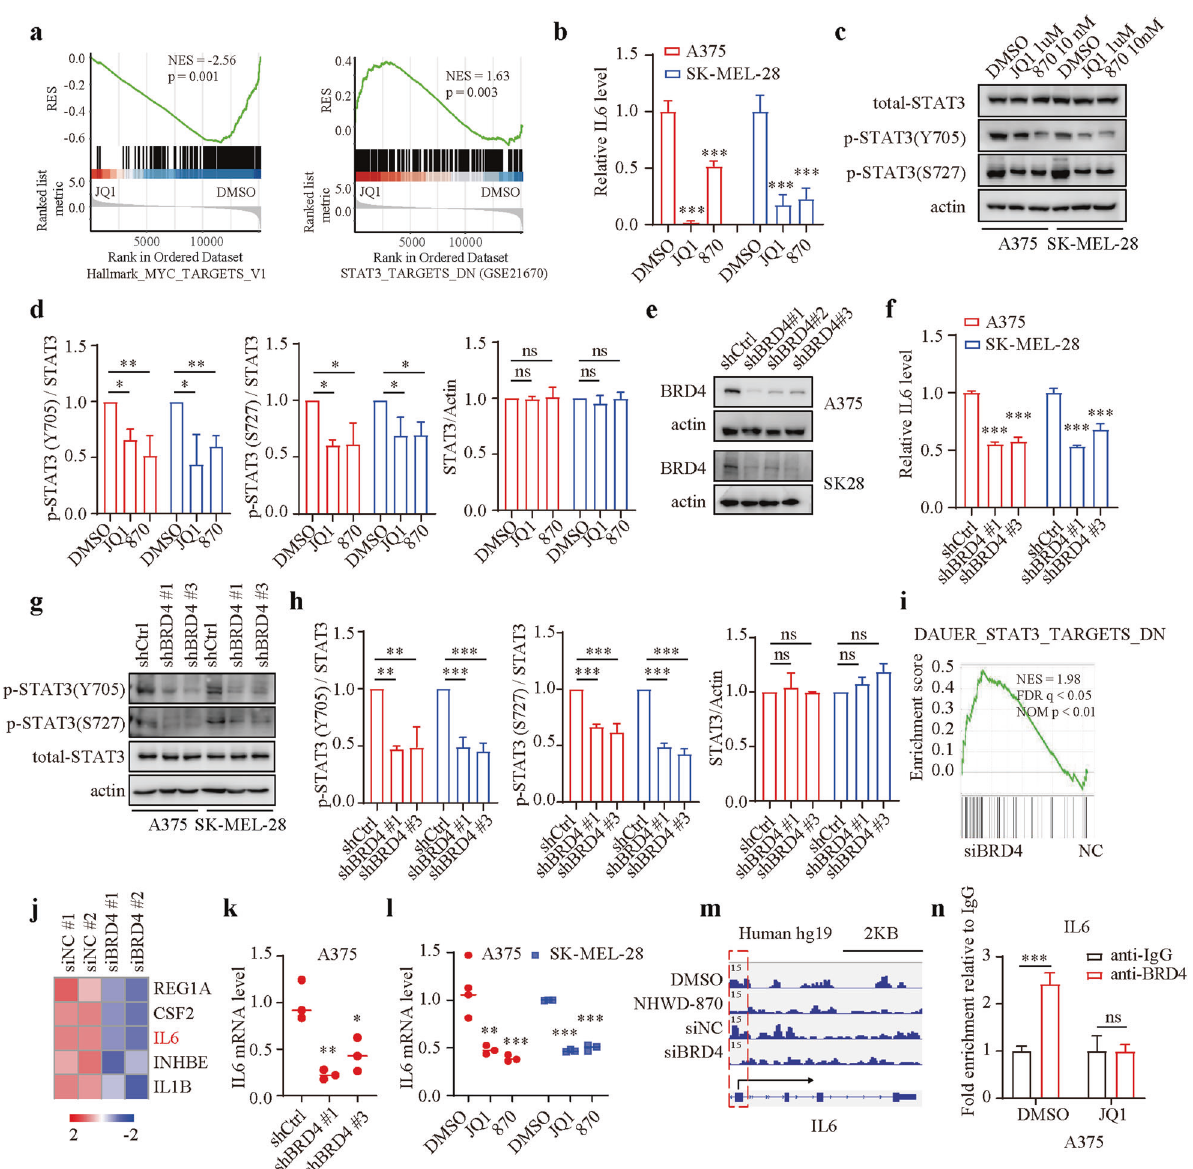
Fig. 4 BET inhibitors repress STAT3 signaling via the BRD4/IL6 axis. a GSEA of MYC targets and targets with STAT3-induced downregulation in the JQ1 and DMSO groups. b IL6 concentrations in supernatants were measured by ELISA after treatment with DMSO, 1 μ M JQ1, or 10 nM NHWD-870 for 24 h. c , d Western blotting and qualitative analysis of the indicated proteins in A375 and SK-MEL-28 cells after treatment with DMSO, 1 μ M JQ1, or 10 nM NHWD-870 for 24 h. e Knockdown ef fi ciency of BRD4 quanti fi ed by western blotting. f IL6 concentrations in supernatants were measured by ELISA after BRD4 silencing. g , h Western blotting and qualitative analysis of the indicated proteins in A375 and SK-MEL-28 cells after BRD4 silencing. i GSEA of targets with STAT3-induced downregulation identi fi ed by RNA-seq of siNC vs. siBRD4 A375 cells. j Heatmap of the top fi ve differentially expressed genes in the gene set. k Assessment of the IL6 mRNA level by RT-PCR in A375 cells after BRD4 silencing. l Assessment of IL6 mRNA levels by RT-PCR in A375 and SK-MEL-28 cells after treatment with DMSO, 1 μ M JQ1, or 10 nM NHWD- 870 for 24 h. m BRD4 binding peaks in the IL6 promoter in DMSO-treated, NHWD-870-treated, siNC-treated, and siBRD4-treated A375 cells. n ChIP-qPCR analysis of the IL6 promoter in A375 cells with an anti-BRD4 antibody or IgG after treatment with DMSO or 1 μ M JQ1. P values were calculated using one-way ANOVA in ( b , d , f , h , k and l ). Two-way ANOVA was performed in ( n ). * P < 0.05; ** P < 0.01; *** P < 0.001; ns nonsigni fi